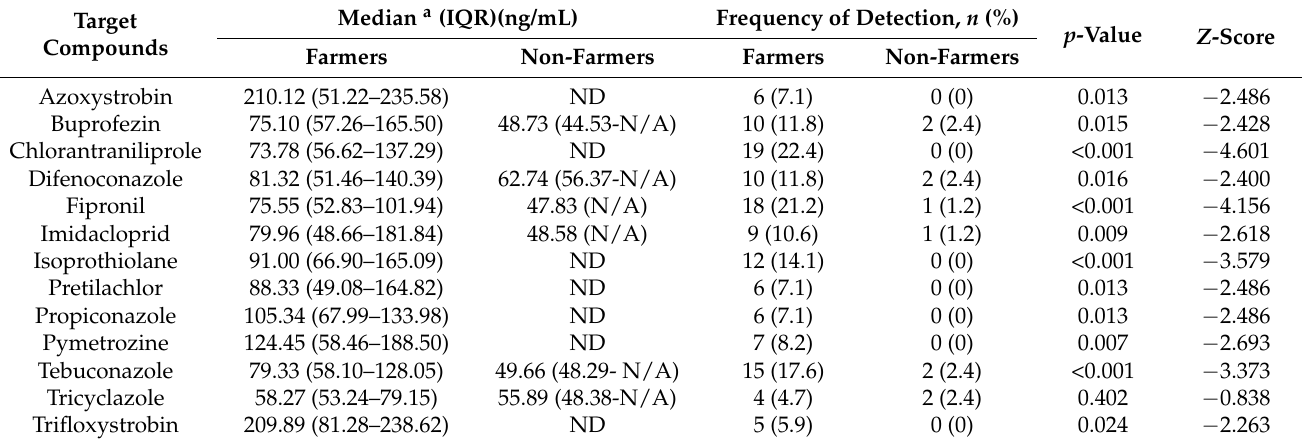
Table 6. Concentration of target compounds detected in blood serum samples of farmers and